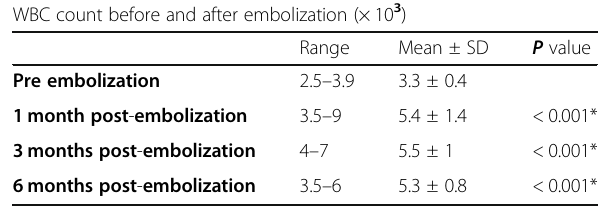
Table 5 Laboratory response based on WBC